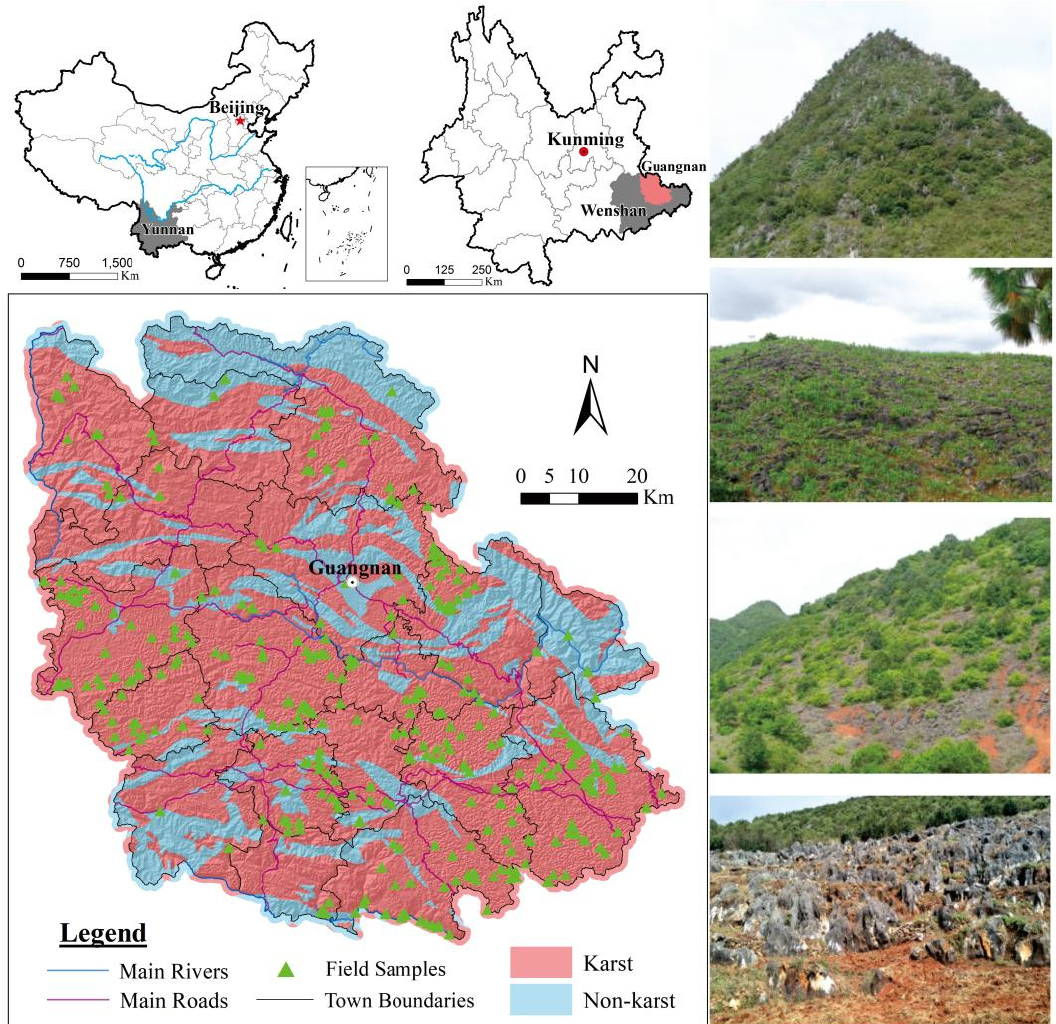
Figure 1. Location of study area and sample pictures: most of the exposed rocks in the karst region show characteristics of small area, dotted shapes on image, and dense distribution.